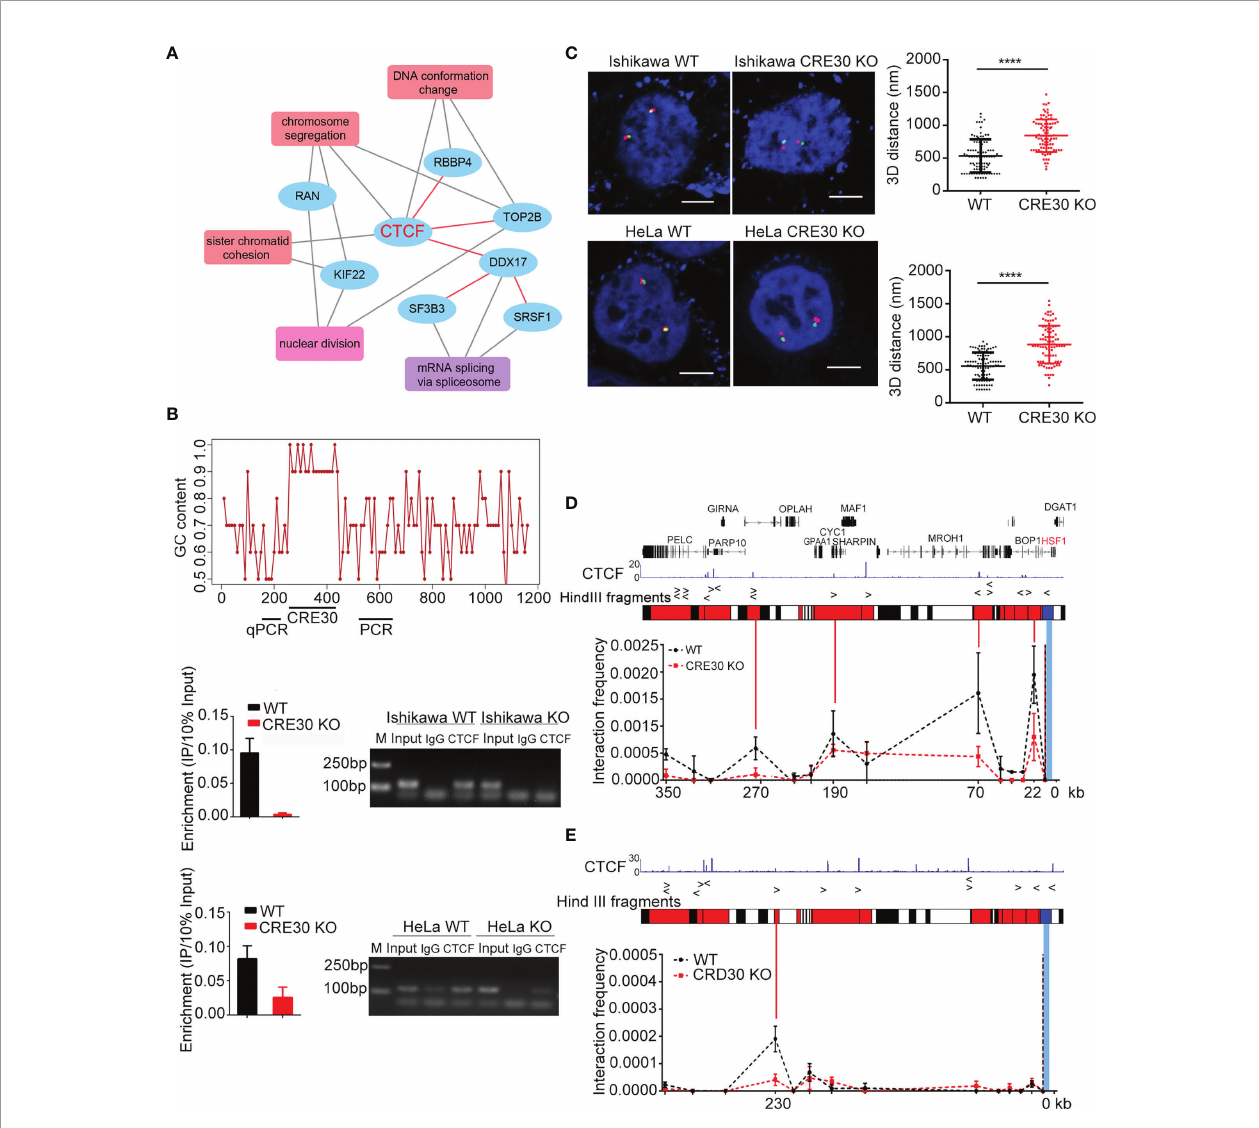
FIGURE 4 | CTCF binding to the CRE30 locus acts to maintain chromatin architecture. (A) Enriched GO terms for CRE30-binding proteins. Black lines indicate the proteins that are included in each item; red lines indicated interaction events between protein candidates. (B) Upper panel, line chart represents genomic GC content (calculated for each of 10 bases) around the sub-CRR95 CRE30 locus. The GC content within the element region was higher than 90%. Horizontal bars on the bottom indicate where ChIP-qPCR and ChIP-PCR primers were designed. Middle (Ishikawa cells) and lower panel (HeLa cells), qPCR (left) and PCR (right) were performed to detect CTCF binding in wild-type and CRE30 deletion cells (n = 3). (C) Left, representative 3D-FISH images of Ishikawa cells (top) and HeLa cells (bottom) before and after CRE30 deletion. Boundary loci of sub-CRR (red and green) and DAPI (blue) are shown. Scale bars indicate 5 m m. Right, scatter diagrams show 3D distance between adjacent red and green spots, suggesting a larger distance after CRE30 deletion. Asterisks indicate the signi fi cant differences; approximately 90 – 120 loci were counted for each group. (D, E) 3C-qPCR at the sub-CRR95 region. CTCF binding peaks are shown on the top according to previous ChIP-seq data in Ishikawa (ENCFF961BQG, ENCODE) and HeLa cells (38). Middle, bars illustrate Hind Ш sites across the region. Based on the CTCF-binding location, bait fragment (blue) and interacting fragments (red) were designed and tested. Line chart at the bottom showed looping intensity in Ishikawa (D) and HeLa (E) cells. Bait fragment is indicated by the blue bar, and interacting fragments are shown by red solid lines. Multiple interaction peaks were detected in wild-type samples (black dotted lines), which declined in CRE30-deletion samples (red dotted lines) (n ≥ 2). **** indicates where t-test, p <